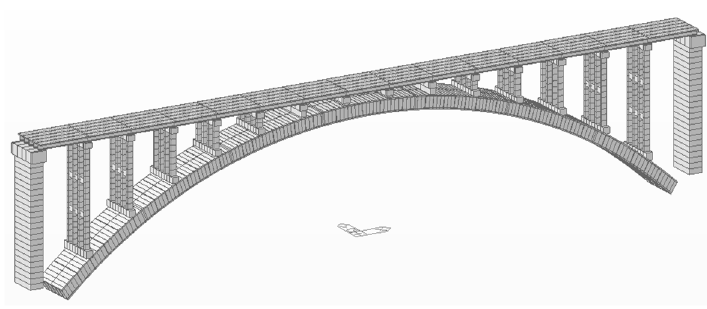
Figure 7. The finite element model of the arch bridge.